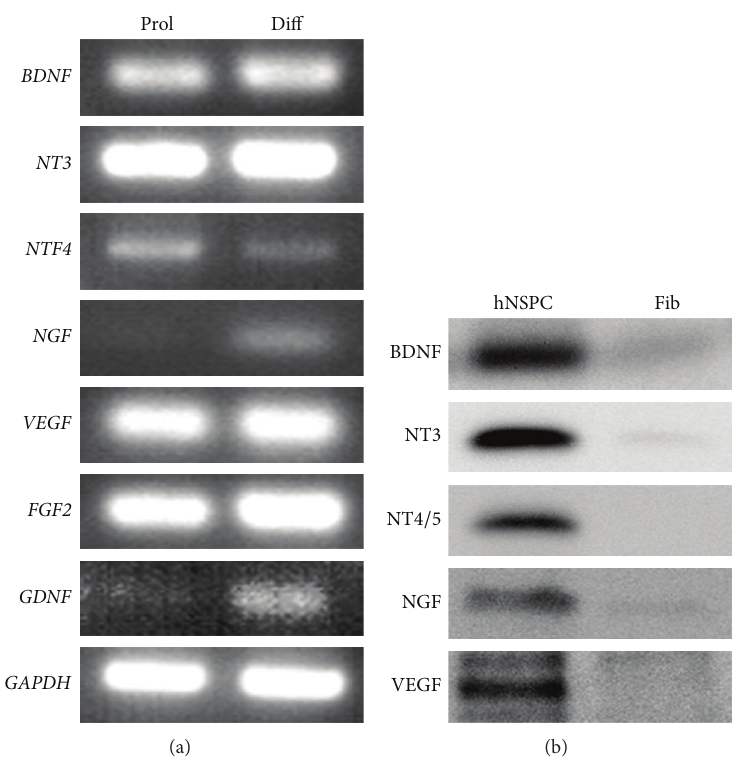
Figure 7: Human NSPCs express diverse trophic factors. (a) In vitro , proliferating (Prol) and differentiated (Diff) hNSPCs, respectively, expressed FGF2 , GDNF , VEGF , and neurotrophins including BDNF , NT3 , NTF4 , and NGF . (b) hNSPCs notably secreted BDNF, NT3, NT4/5, NGF, and VEGF into the cultured media, compared to human foreskin fibroblasts